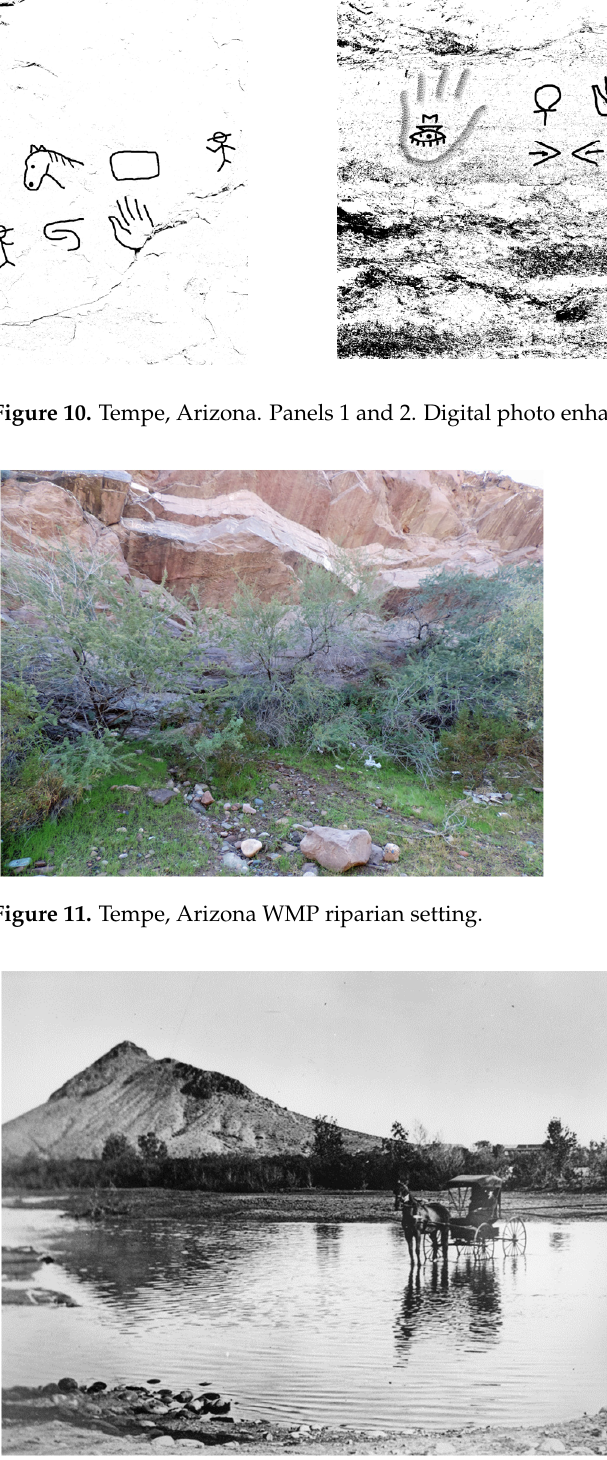
Figure 12. Salt River, Hayden Butte, Tempe, Arizona. Photographer unknown, 1870s–1880s.